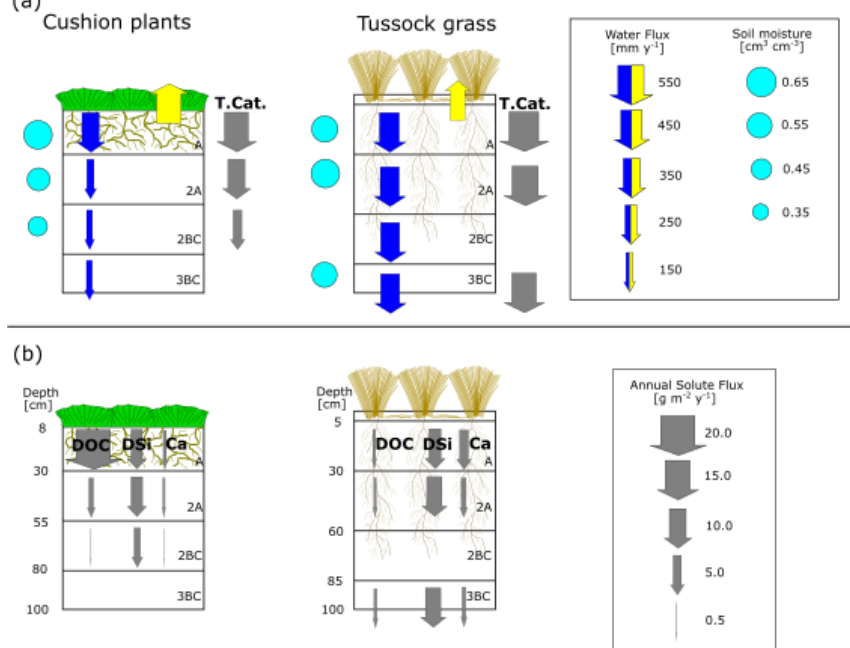
Figure 10. (a) Mean annual water fluxes, contemporary soil weathering rates, and soil moisture and (b) solute fluxes at different soil horizons under cushion-forming plants and tussock grass. The vertical arrows represent fluxes, of which size and direction indicate flux quantity and direction of flow. The blue and yellow arrows represent water fluxes: infiltration and ETa, respectively. The gray arrows represent soil chemical weathering rates (T.Cat.) and solute fluxes. Root depth, abundance, and diameter drawn as per Páez-Bimos et al.